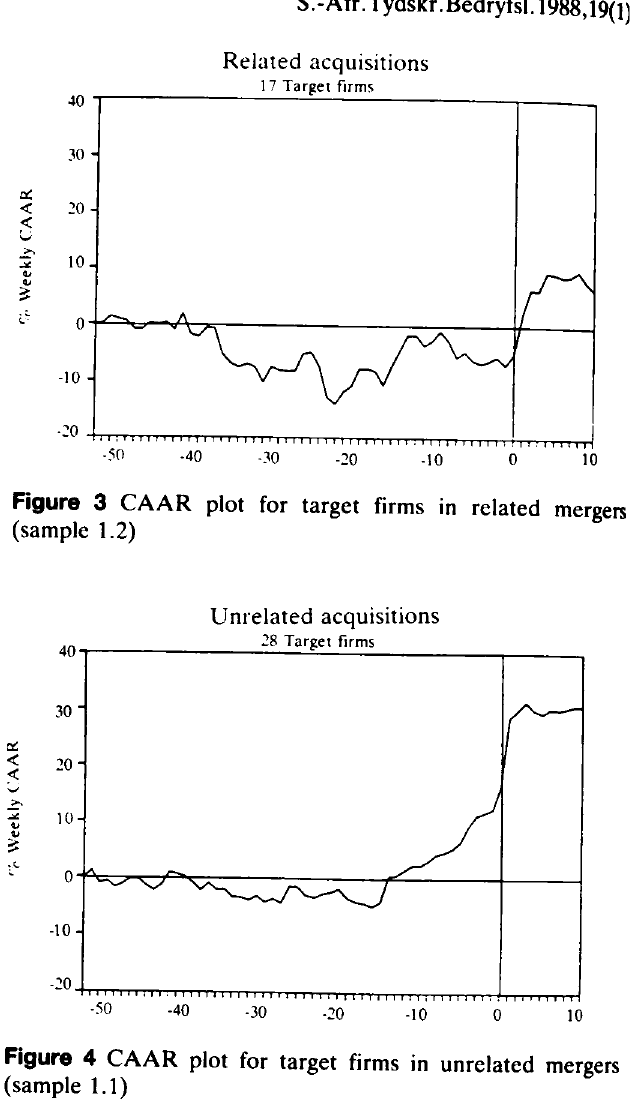
Figure 4 CAAR plot for target firms in unrelated mergers (sample